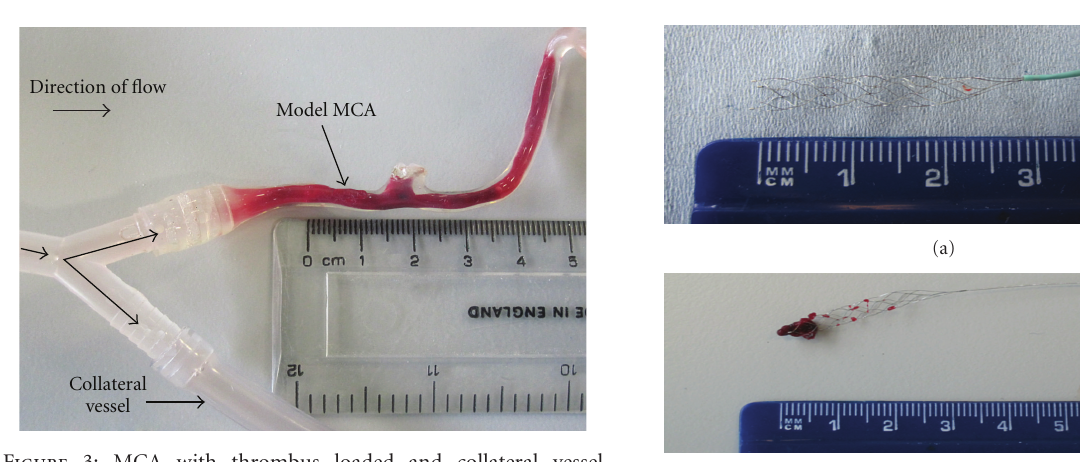
Figure 3: MCA with thrombus loaded and collateral vessel displayed.